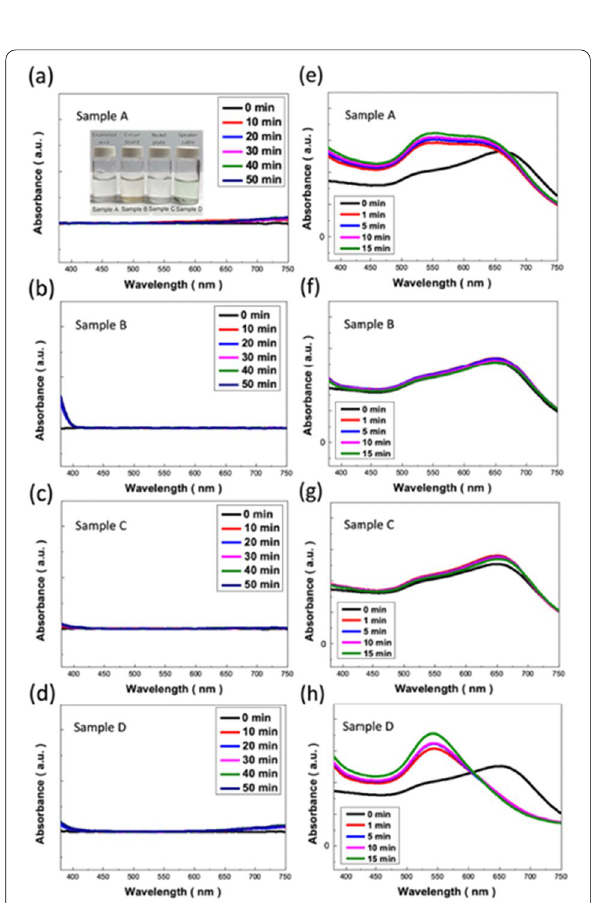
Fig. 5 UV/Vis absorption spectra of bare tested solutions: a Sample A b Sample B c Sample C and d Sample D, respectively. The inset figure of Fig. 5a presented the photographs of tested solutions for further detection. UV/Vis absorption spectra of e Sample A f Sample B g Sample C and h Sample D in the presence of LS‑AuNP probes, respectively, where the obvious colorimetric detection for selectively sensing Cu 2 + ions could be